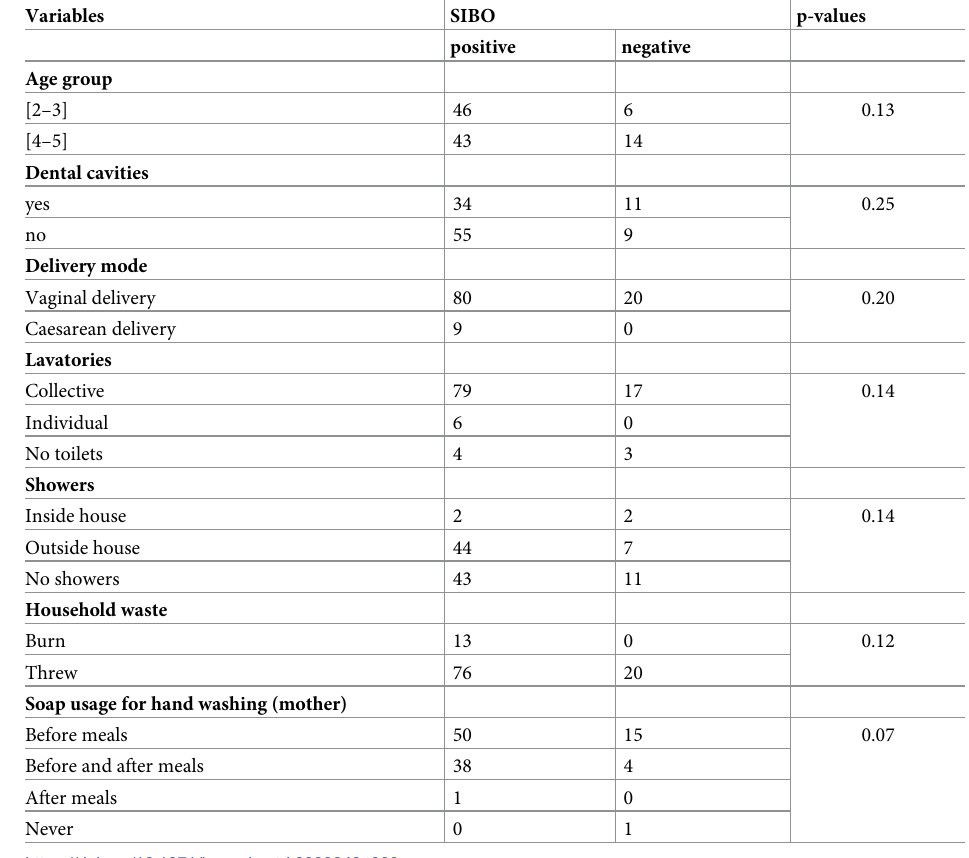
Table 4. Comparison between stunted children and controls for the presence of bacterial diarrheagenic agents in fecal samples. % for controls (N = 264) % for MS = (N = 104) % for SS = (N = 96) P-value � Salmonella spp. 7.95 (N = 21) 0.13 Shigella spp.